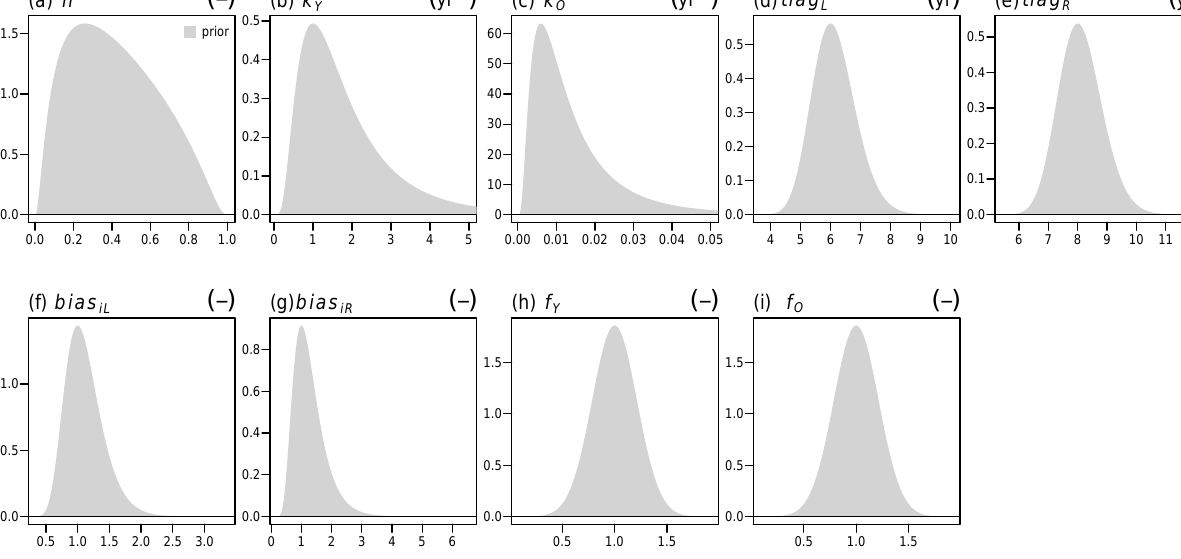
Fig. 2. Prior distributions used for the model parameters θ . Distributions: (a) h logit-normal distribution, (b) k Y and (c) k O log-normal, (d) tlag L and (e) tlag R log-normal (priors for Coulissenhieb II and Solling are shown), (f) bias iL and (g) bias iR log-normal distributions, (h) f O and (i) f Y truncated normal distributions.